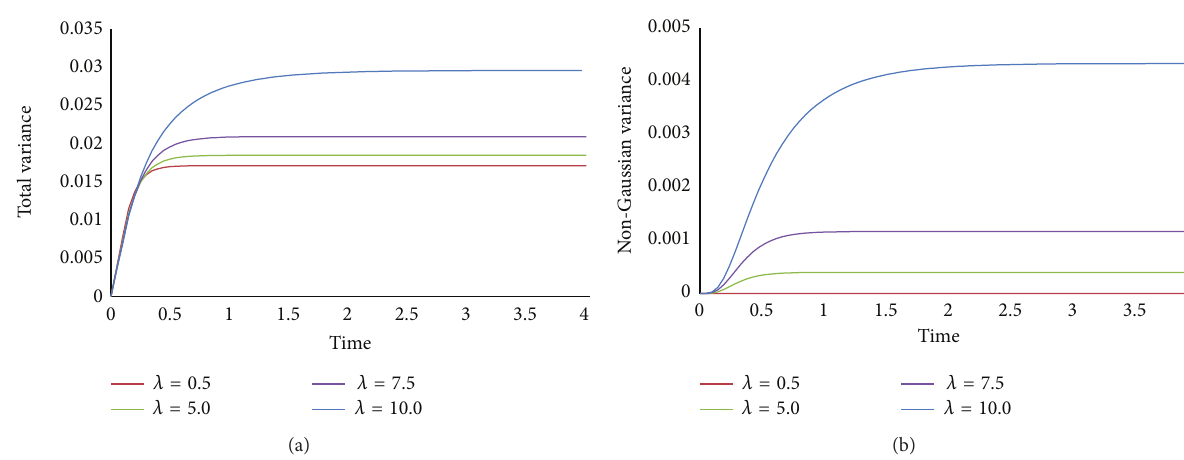
Figure 7: Total variance (a) and the non-Gaussian variance (b) for different values of the nonlinearity strength 𝜆 .